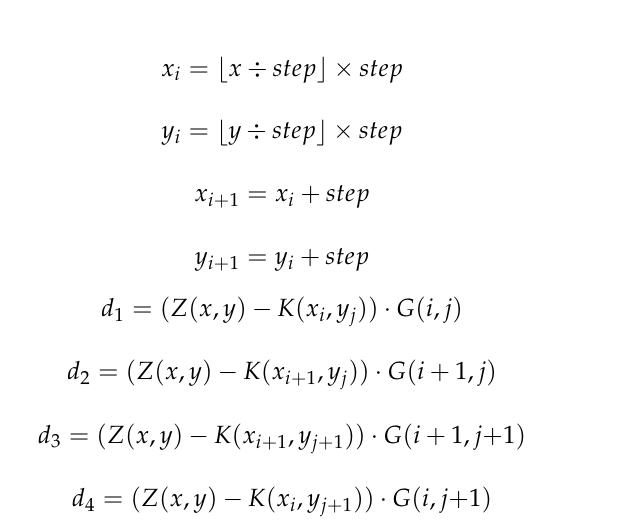
Interpolation calculation. Set the interpolation function as f ( x ) = 6 x 5 − 15 x 4 + 10 x 3 [36]. As shown in Function (10), x − x i is substituted into function f ( x ), and the interpo- lation operation is carried out in the x-axis direction; the results C 1 and C 2 can be obtained. Then, C r can be calculated through Function (11) to carry out the inter- polation operation in the y-axis direction. The noise result under a single sampling frequency and amplitude can be calculated using Function